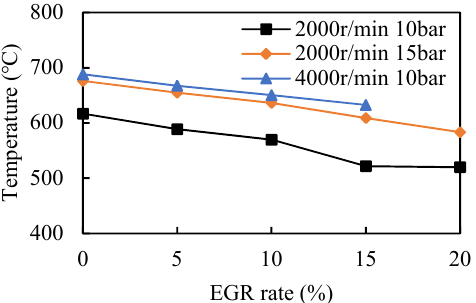
Figure 4. The exhaust gas temperature changes with the increase in EGR rate.